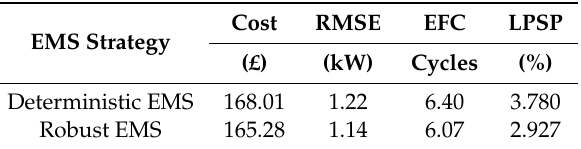
Table 3. Performance indices during a simulation of one-week duration. EFC: equivalent full cycles; LPSP: loss of power supply probability.